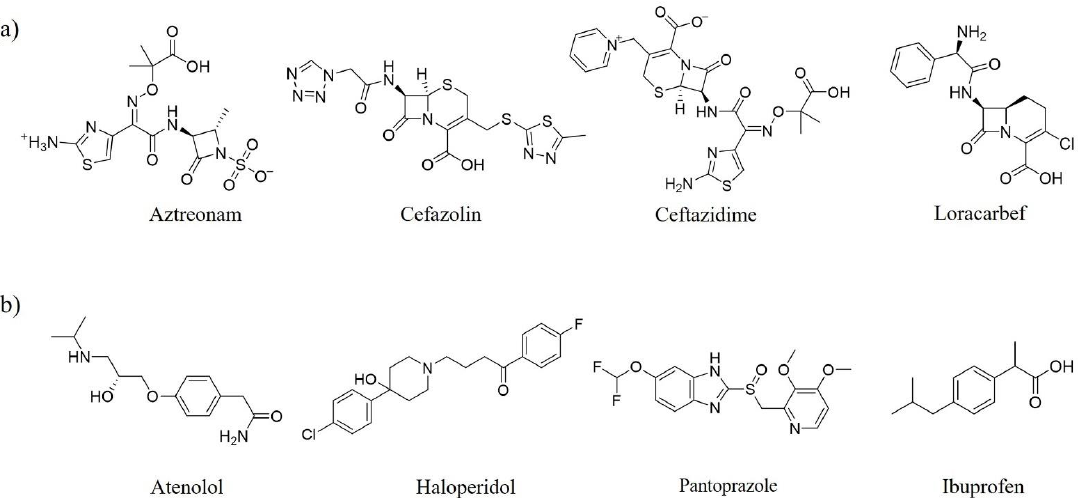
Figure 4. ( a ) The structure of the DITP t oxicants with the β -lactam ring correctly identified by the CCMD + KPFP-XGBoost and RDMD + PubChem-k-NN models. ( b ) Structure of DITP toxicants mis- classified by the CCMD + KPFP-XGBoost